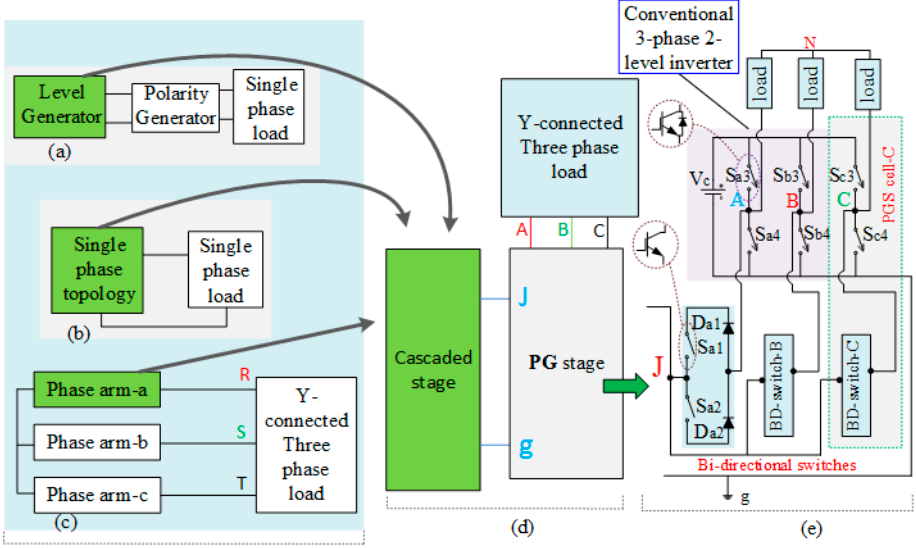
Figure 1. Block diagrams: ( a ) level and polarity generators-based cascaded multilevel inverter (CMLI) topology; ( b ) CMLI topology with no polarity generator; ( c ) 3-phase CMLI topology; ( d ) proposed 3-phase CMLI; ( e ) Circuital model of the PG-stage. Reprint with permission [4261051118814]; 2018, IEEE.